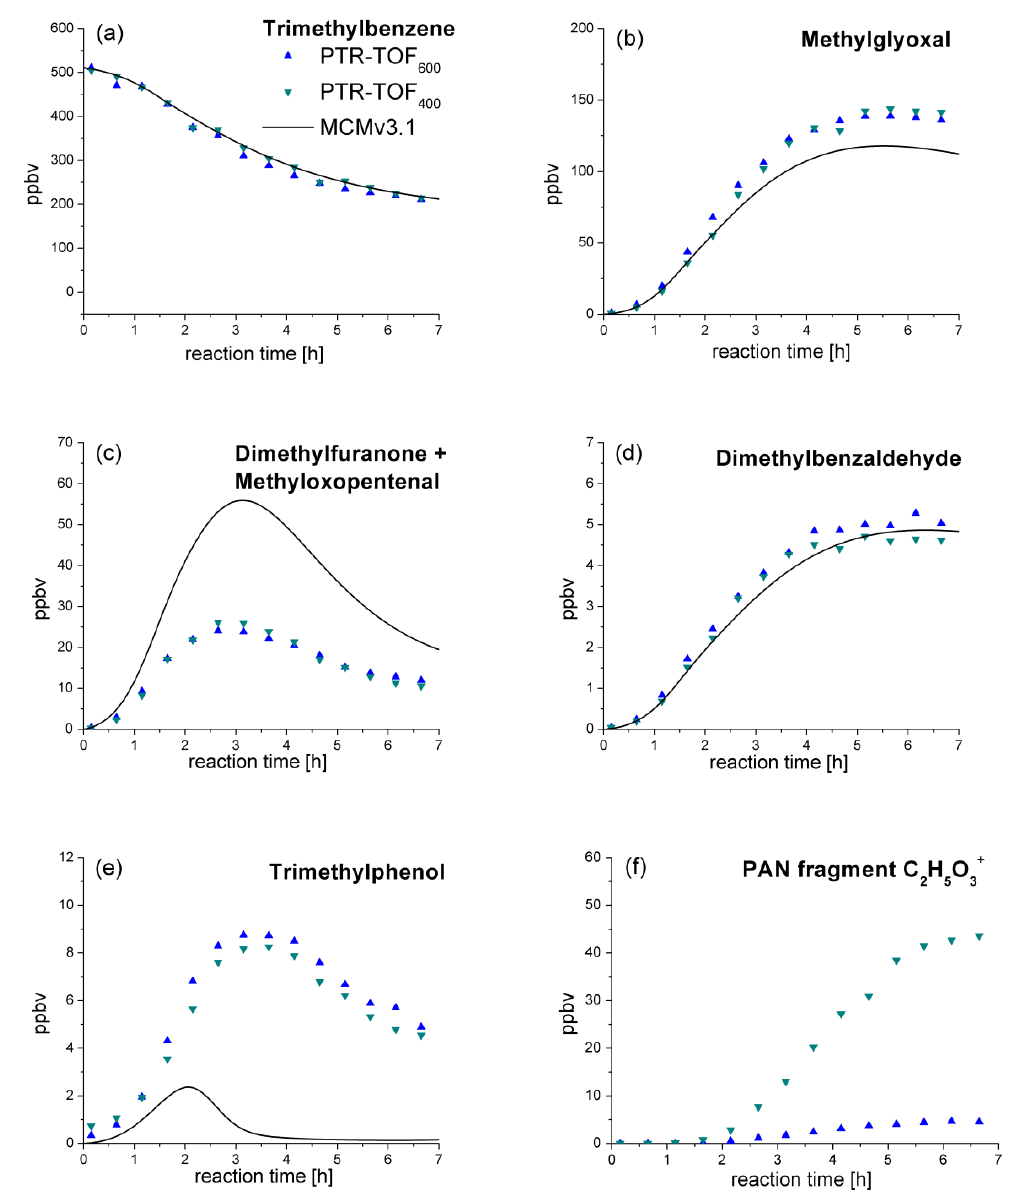
Figure 3. Time evolution of (a) TMB and (b) – (f) selected TMB degradation products as measured during experiment 1a (PTR-TOF 600 ) and experiment 1b (PTR-TOF 400 ) . The black line illustrates corresponding MCMv3.1 predictions. The measured C 3 reaction products shown in panel (b) are dominated by methylglyoxal. Measured data are in good agreement with model expectations. About 60 ppbC of the higher C 3 product signal can be explained by the difference of the measured and the expected methylglyoxal concentra- tion.